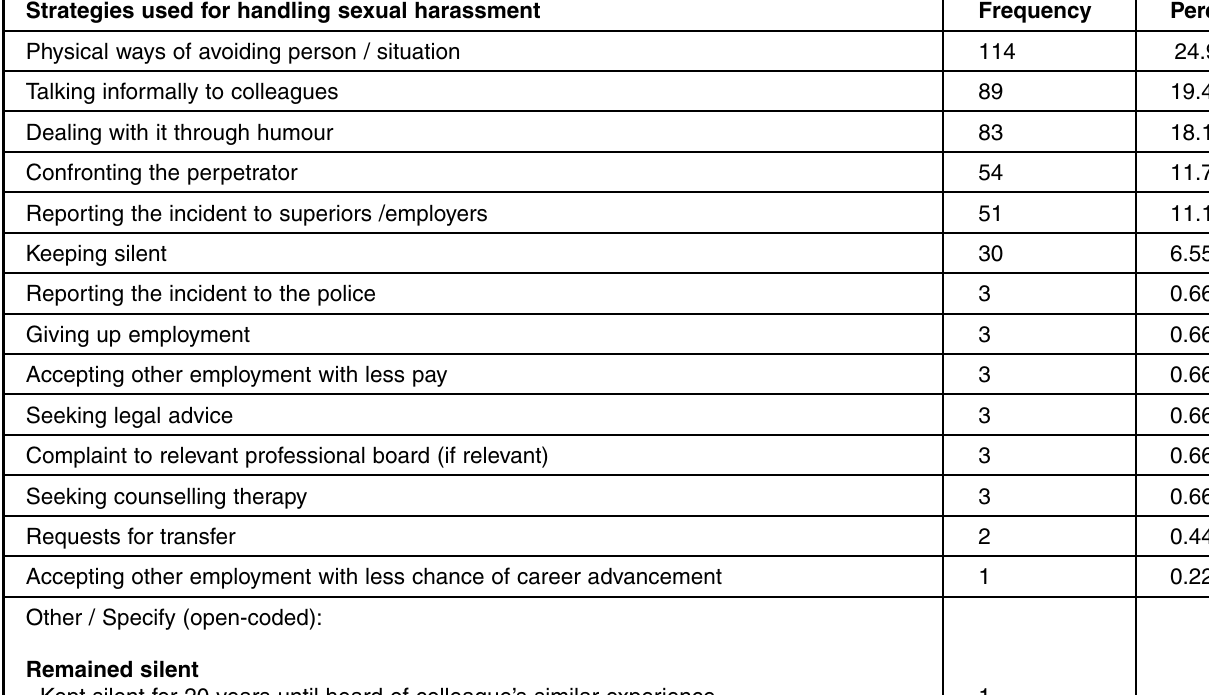
Table 1: Strategies that the respondents used to handle worst incidents of sexual harassment Strategies used for handling sexual